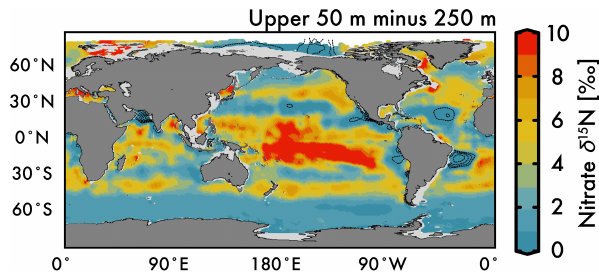
Figure 6. Difference between the average nitrate δ 15 N in the upper 50m and 250m depths in Fig. 5. Dashed contours in low-latitude ODZ regions and subtropical gyres indicate regions where nitrate δ 15 N at 250m is greater than the upper 50m nitrate δ 15 N.